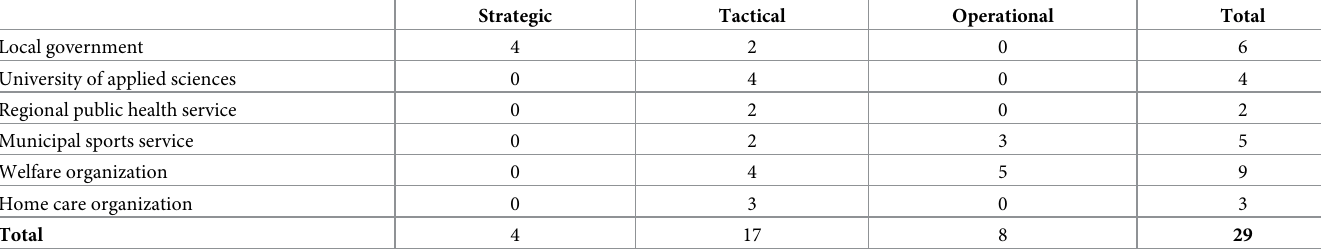
Table 1. Overview of involved organizations and the number of respondents that work for that organization. n = 29. Strategic